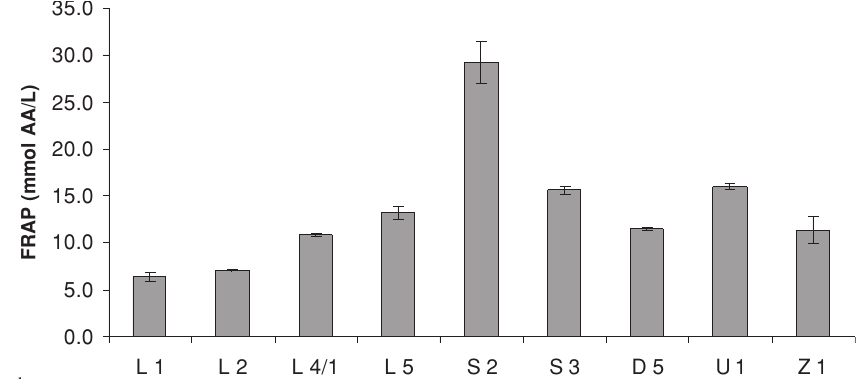
Figure 1. Antioxidant capacity in fruits of Prunus spinosa and P. insititia selections, collected in 2009, Lövôpetri, Hungary.